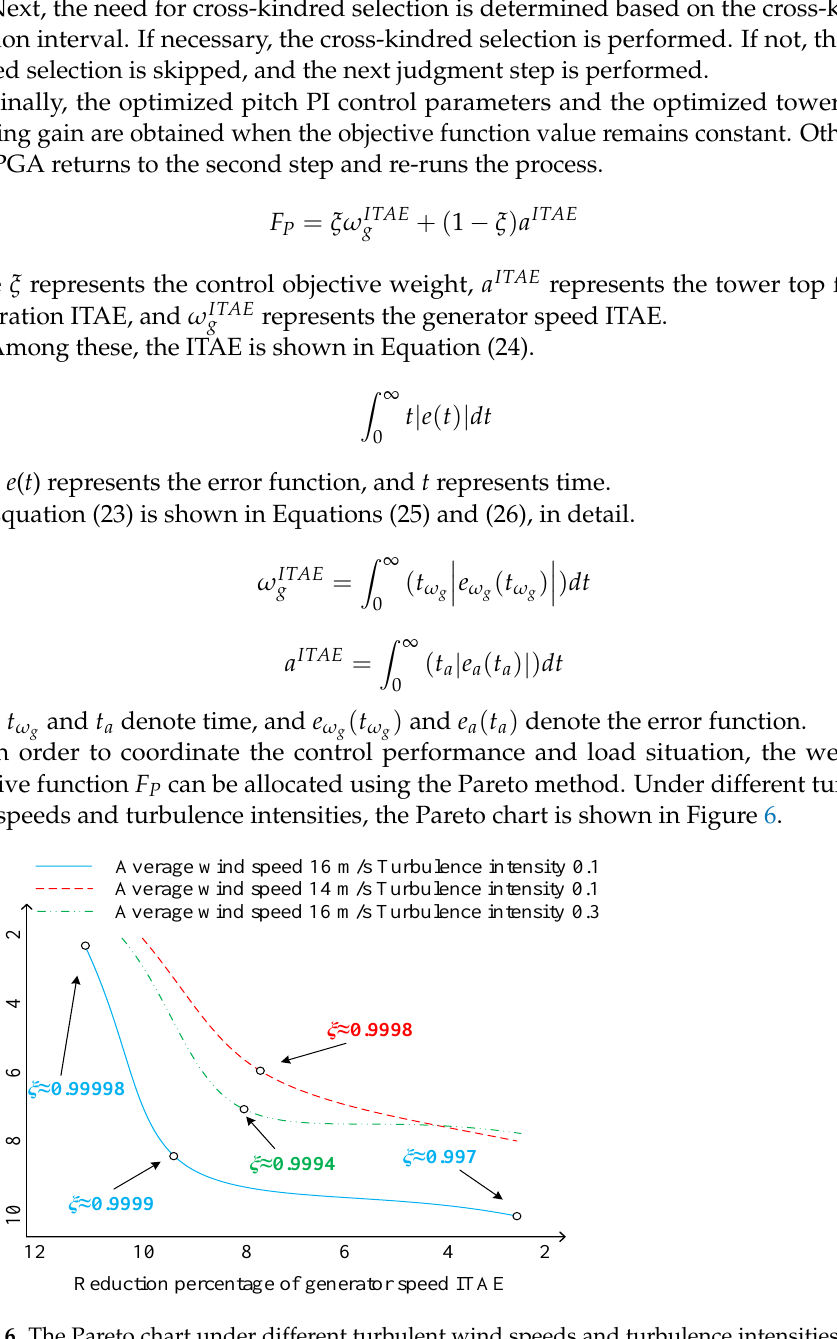
According to the result of weight allocation, the K p , K i , and K a at a wind speed of 16 m/s can be optimized using the proposed KPGA method. Therefore, the change curve of the objective function values under different wind conditions is shown in Figure 7. In ad- dition, since the objective function value is just a numerical value, it has no units. Figure 7. The change curve of the objective function. It can be observed from Figure 7 that the optimized pitch PI control parameters and active damping gain obtained by KPGA show high accuracy, as the population genera- tions are increasing. Under the same turbulence intensity, the optimization results are